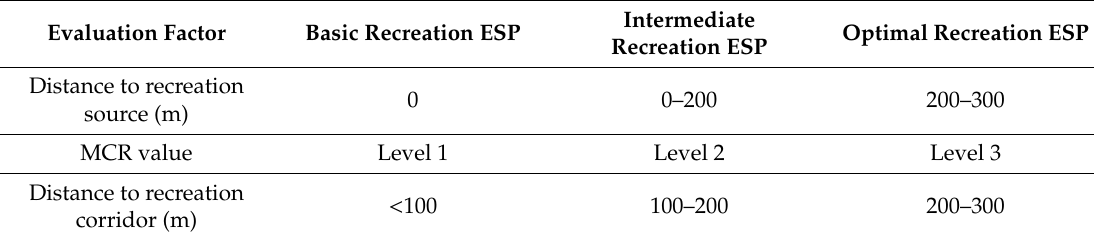
Table 10. Criteria for recreation ESP